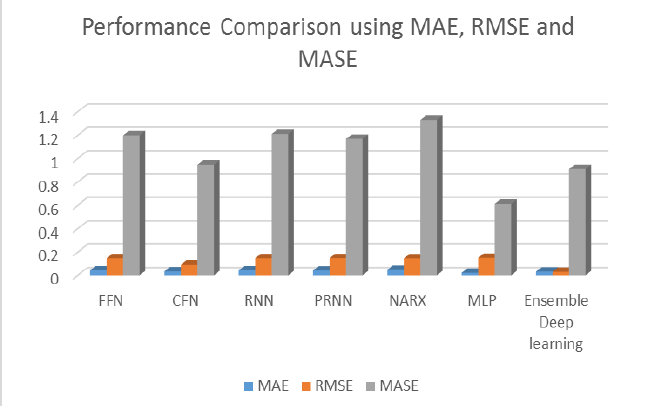
Figure 7: Comparison of models based on Classification Accuracy.